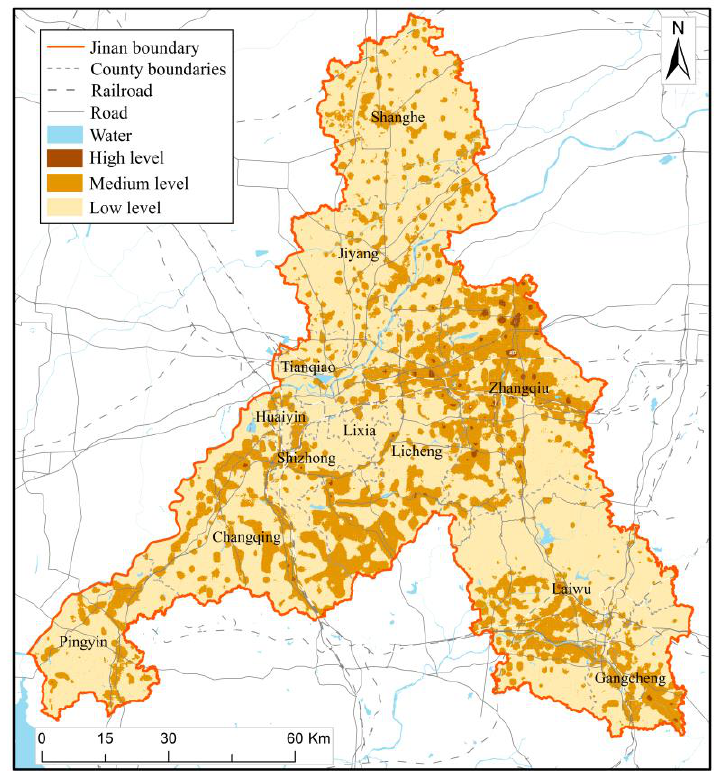
Figure 5. Result map of vulnerability assessment.